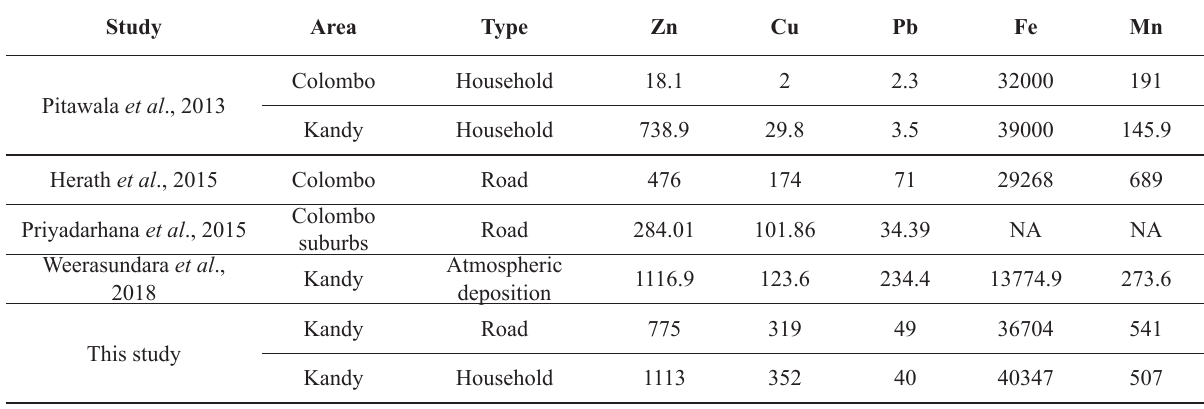
Table 5: Comparison of mean concentrations (mg kg -1 ) of heavy metals in dust in different cities in Sri Lanka.